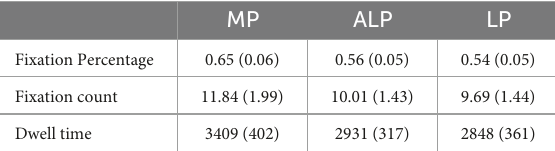
TABLE 2 Means (SD) for total area of interest (IA) fixations in different